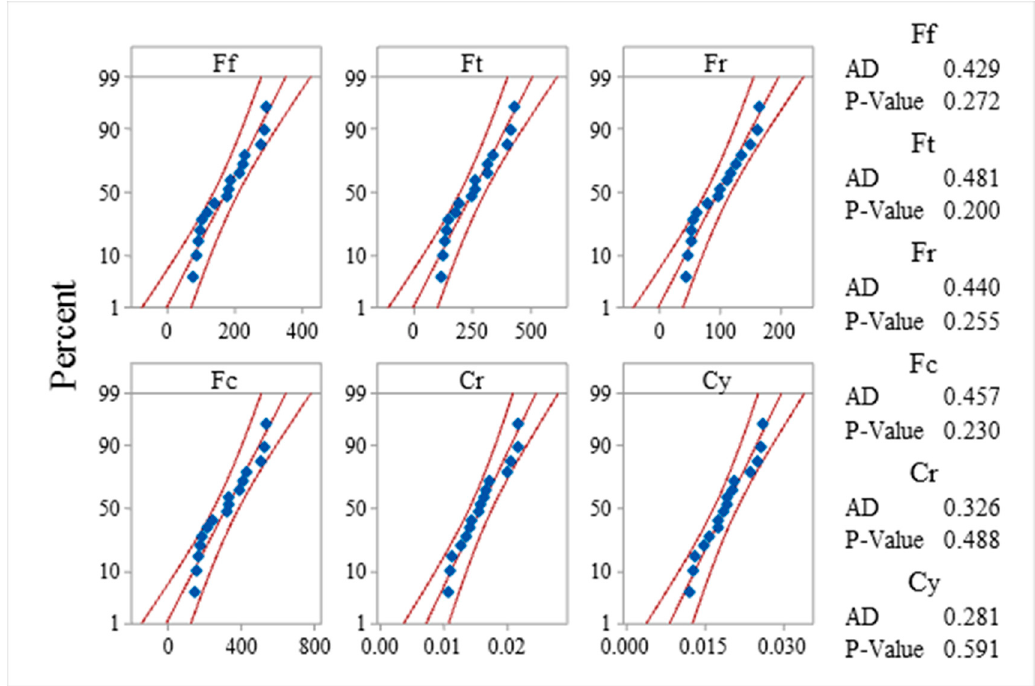
Figure 4. Probability plots for responses. AD: Anderson Darling test.